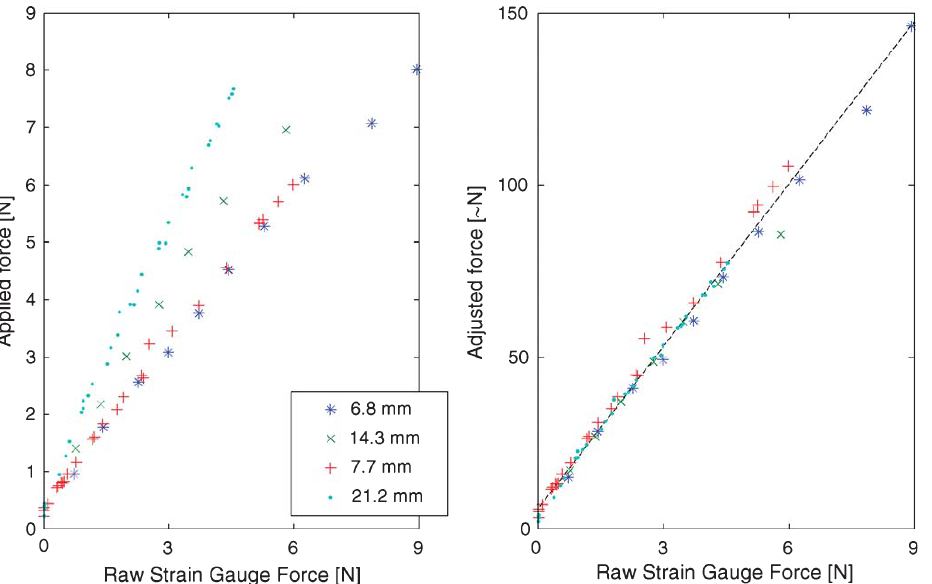
Fig. 9. (Left) The applied force as measured by the digital force gauge is plotted against the measured force. Each shape represents a different jaw angle. (Right) The transformed force plotted against the measured force showing how the dependence on jaw angle has been removed. The linear fit described by Equation 13 is also